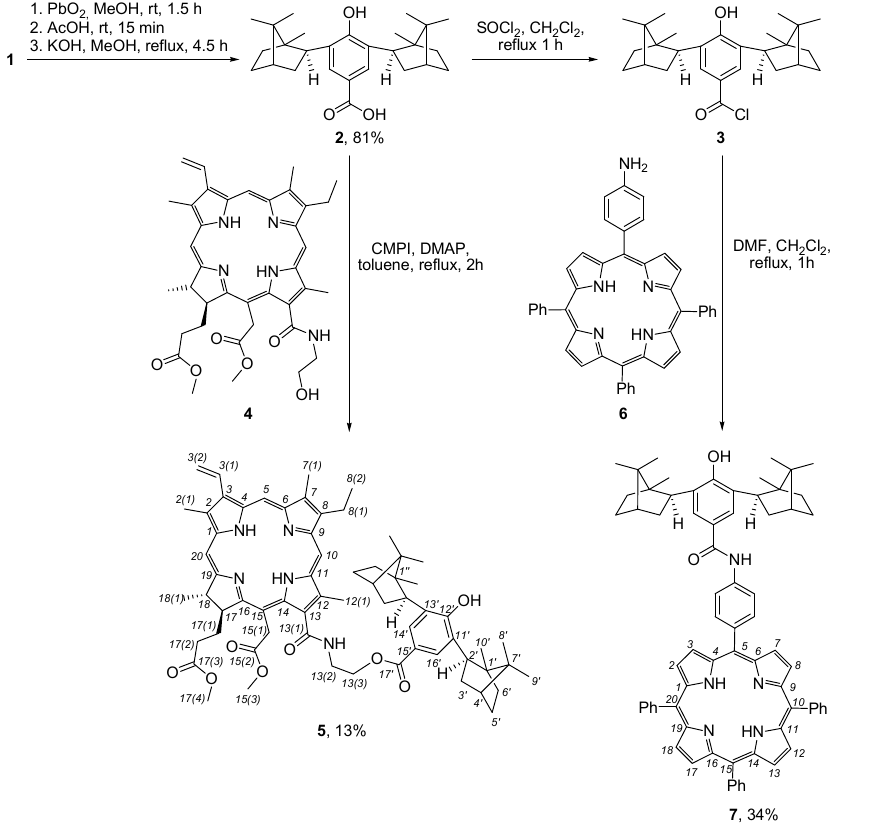
Scheme 1. Synthesis of porphyrin conjugates with 2,6-diisobornylphenol.